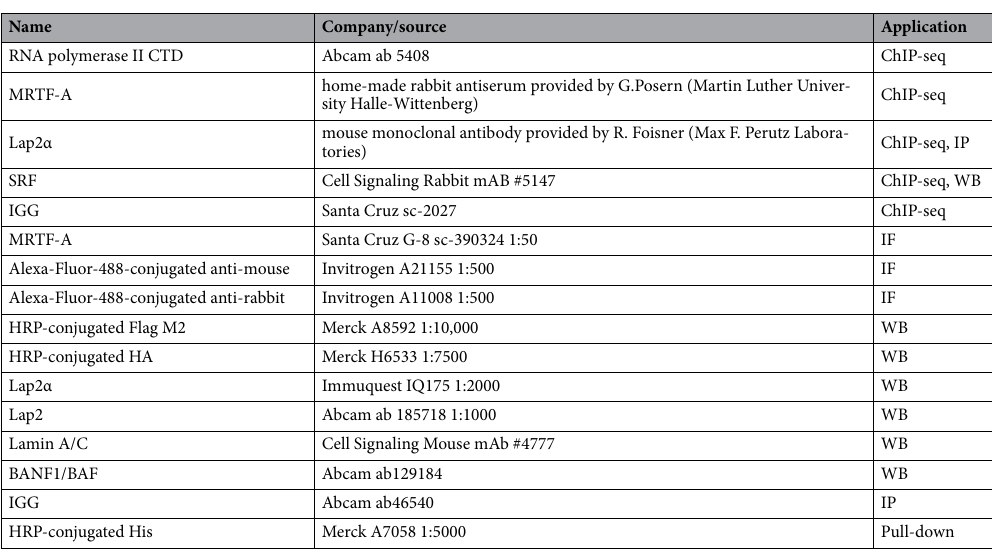
Table 1. List of antibodies used in the